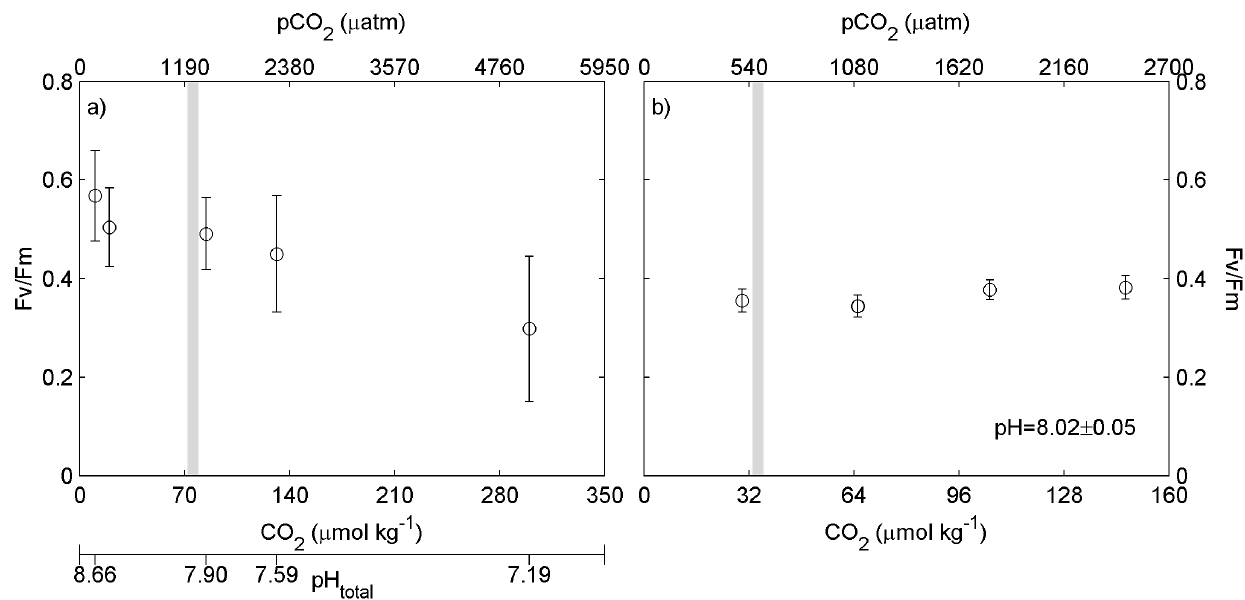
Figure 2. Maximum quantum yield (F v /F m ) of brine algae with varying pH and pCO 2 . a: Maximum quantum yield (F v /F m ) of the brine algal incubations with varying pH in November 2012, experiment 1. b: Maximum quantum yield (F v /F m ) of the brine algal incubations with constant pH and varying CO 2 in November 2012, experiment 2. Vertical grey line signifies initial pH and pCO 2 .